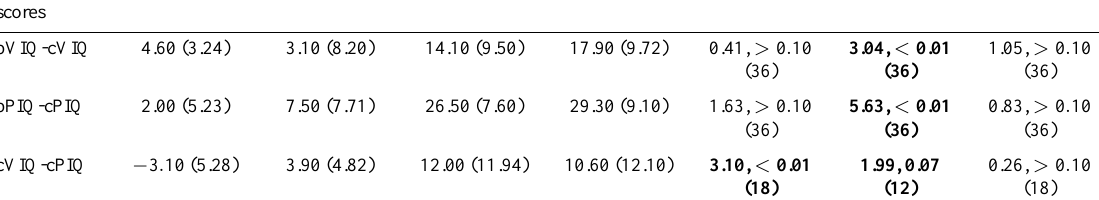
Table 2 Planned comparisons [ t value, probability value, (df